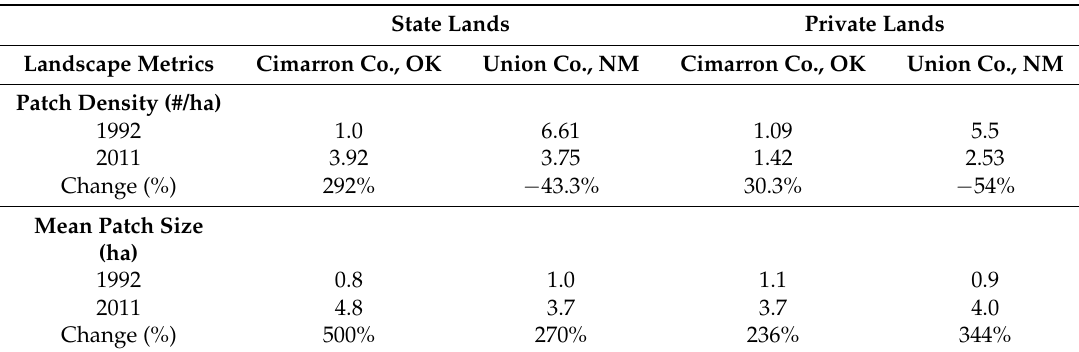
Table 4. Landscape metrics computed for shrubland on state and private lands in Cimarron, Co., OK and Union, Co., NM, 1992–2011.